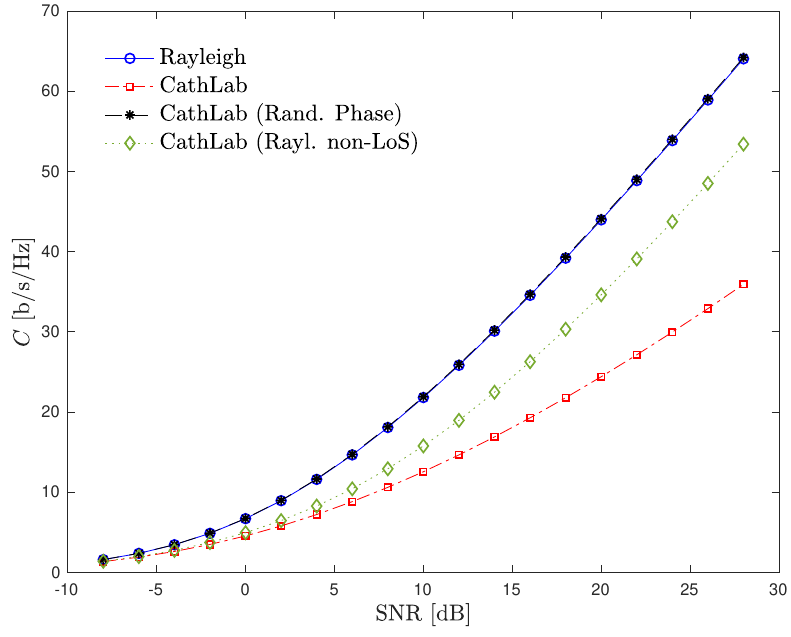
Figure 12. Ergodic capacity of an 8 × 8 MIMO-OFDM system considering different CathLab